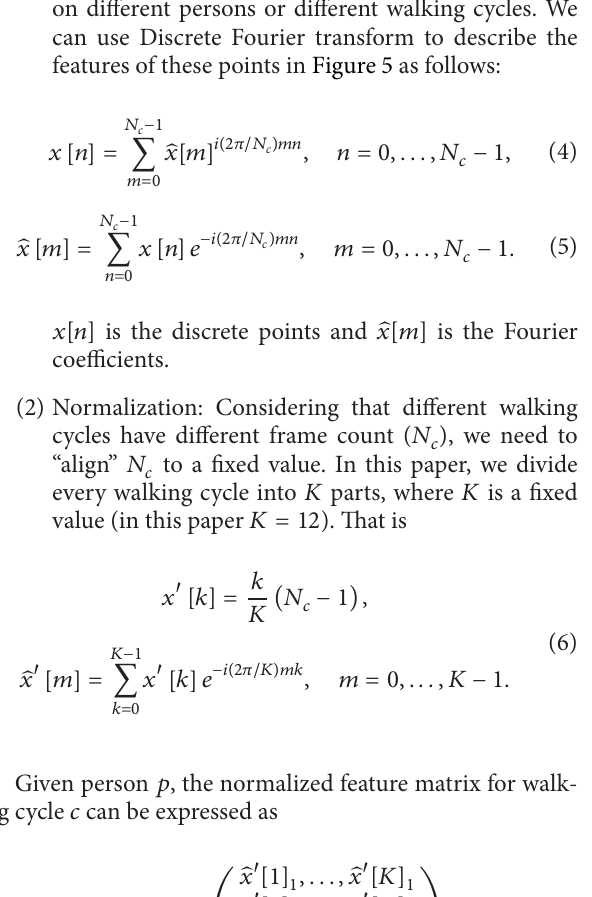
Figure 4: A human Gait cycle.